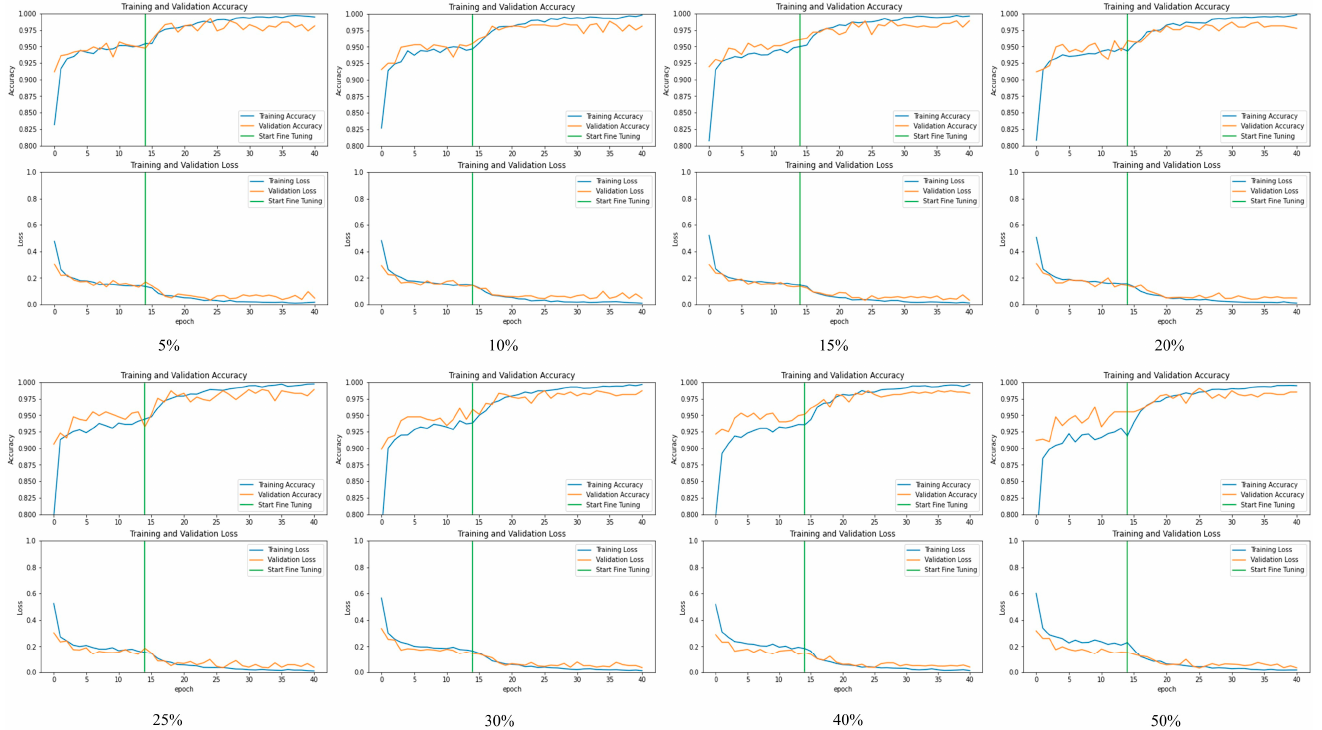
Figure 7. The relationship between accuracy and loss with the number of epochs for the dataset before and after fine-tuning the Inception V3 model with 5%, 10%, 15%, 20%, 25%, 30%, 40%, and 50% dropout values.